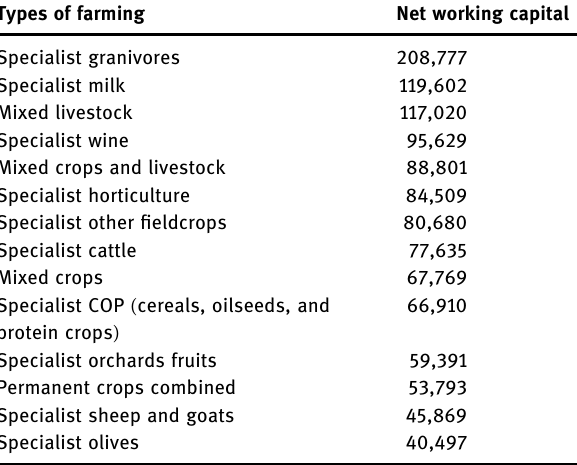
Table 1: Net working capital ( euros ) for the former 28 European Table 2: Net working capital ( euros ) for the 14 types of farming,